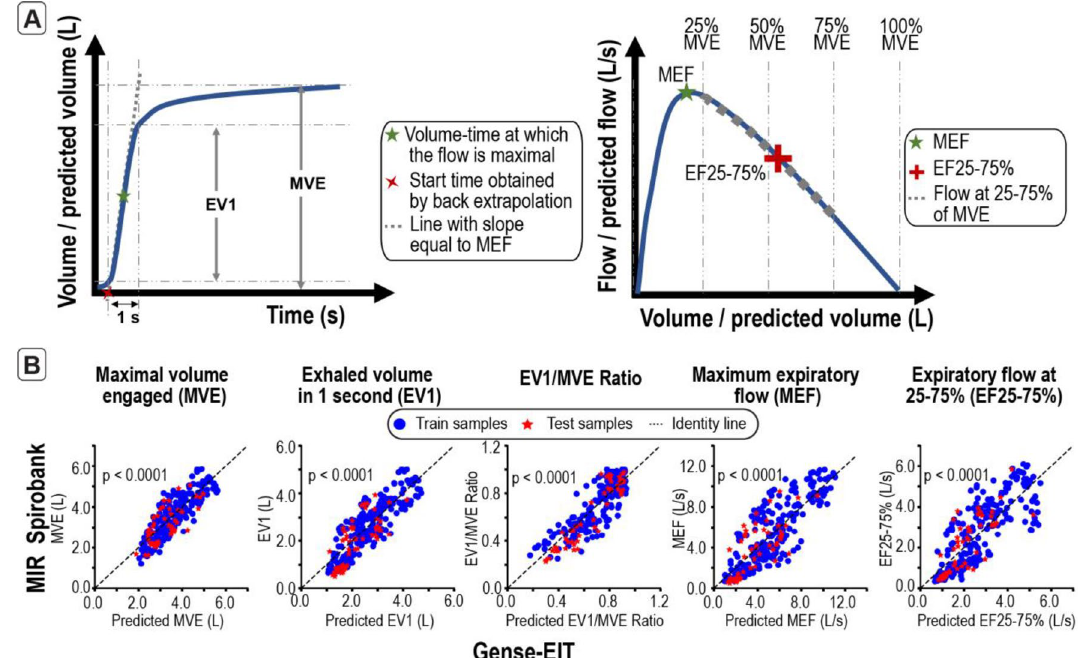
Figure 3. The spirometry indicators predicted with the EIT device are significantly correlated with the indicators from a standard spirometer, demonstrating the capability of the developed EIT system to infer standard lung function indicators. ( A ) Illustration of the method used for calculating the spirometry indicators 7 ( B ) EIT-derived indicators are significantly correlated with spirometry indicators across a wide dynamic range for both training and testing samples, demonstrating that the device has standard spirometry capabilities. Abbreviations: Maximal volume engaged (MVE), exhaled volume in 1 s (EV1), maximum expiratory flow (MEF), expiratory flow at 25–75% of maximum volume engaged